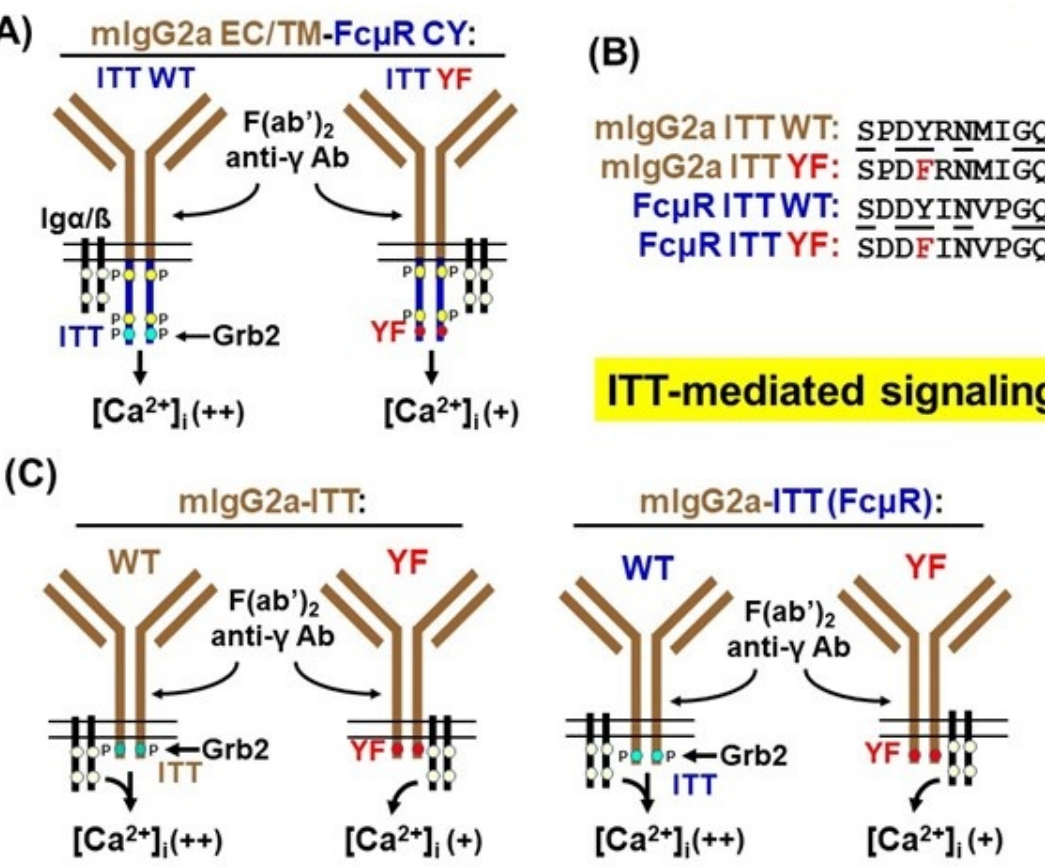
Figure 4. Signaling function of the ITT-like motif of FcµR. ( A ) Chimeric IgG2a BCR consisting of the extracellular and transmembrane regions of membrane IgG2a (mIgG2a; brown) and the cytoplasmic tail of FcµR (blue), along with Ig α /ß (black). ITT tyrosines (light blues) and other tyrosines (light yellow circles). Point mutation of the ITT tyrosine to phenylalanine (YF; red circles). Intracellular Ca 2+ concentration ([Ca 2+ ] i ) and recruitment of Grb2 after cross-linkage of the chimeric mIgG2a BCR by F(ab’) 2 fragments of anti- γ antibodies are indicated. Potential phosphorylation (P) of chimeric IgG2a BCR are also shown based on protein blot analyses. ( B ) Amino acid sequence alignments around the ITT motif of mIgG2a of WT (top row) or YF variants (2nd row) as compared with the ITT motif of FcµR WT (3rd row) or YF (4th row). ( C ) Signaling function of mIgG2a-ITT of WT (1st column) or YF (2nd column), and of mIgG2a-ITT (FcµR) of WT (3rd column) or YF (4th column).